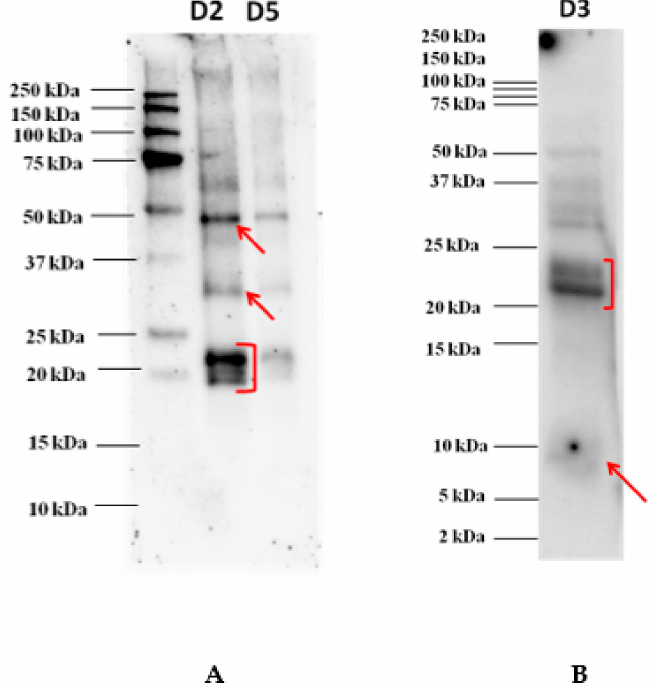
Figure 2. Immunoblot analysis after goji protein separation on AnykD TM gel ( A ) and on Tris-tricine gel (at dilution D3) ( B ). Di ff erent dilutions of goji extract were loaded, namely 1:2 (D2, corresponding to 105 µ g of proteins) and 1:5 (D5, corresponding to 60 µ g of proteins) for AnykD TM gel and 1:3 (D3, corresponding to 120 µ g of proteins) for Tris-tricine gel. Serum was diluted 1:20 in TBS-T before